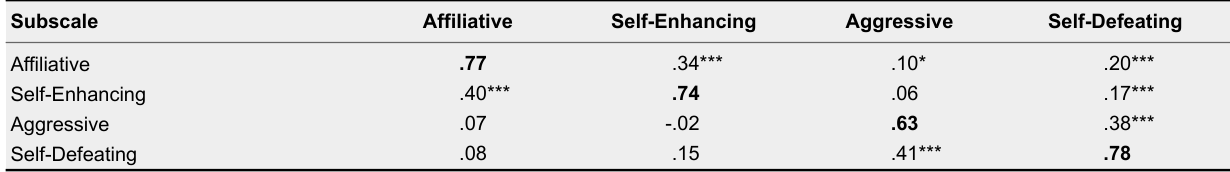
Cronbach’s Alphas and Correlations Amongst the Humor Subscale